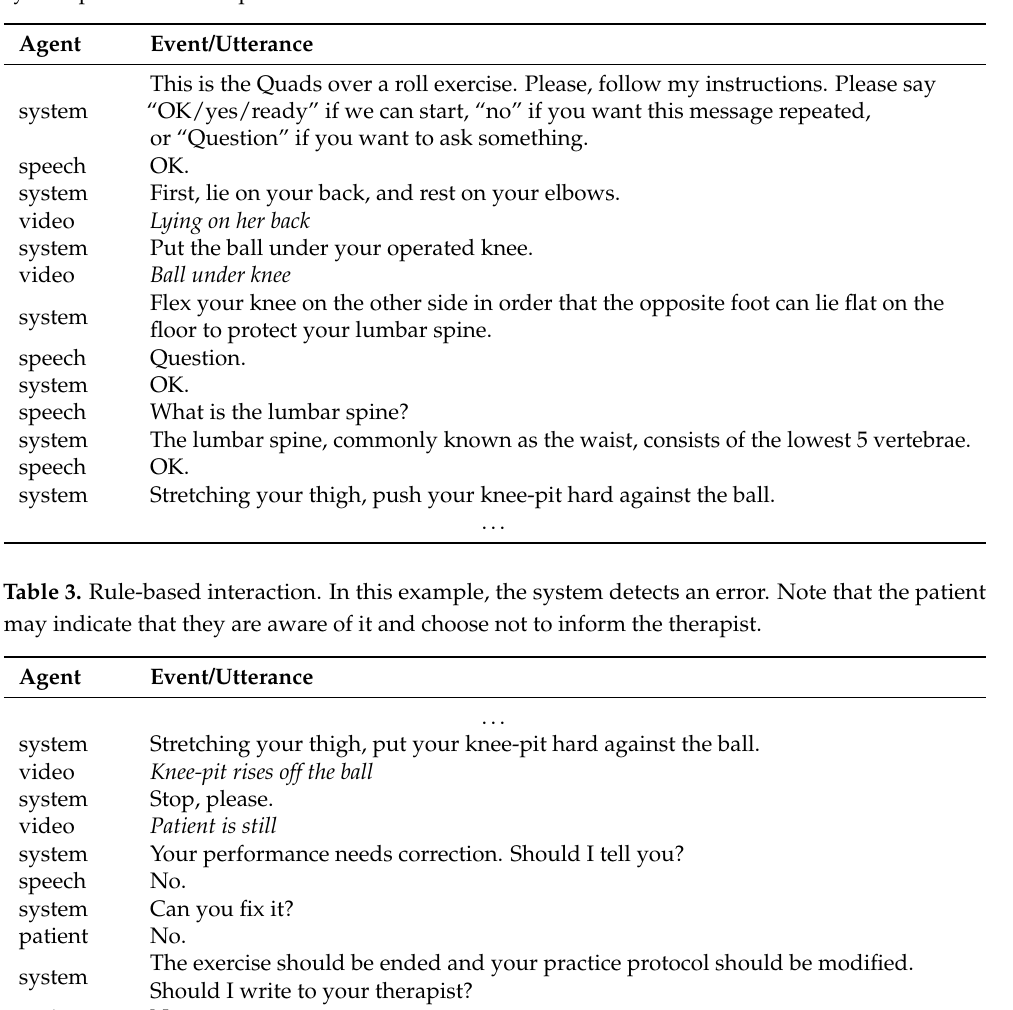
Table 2. Rule-based interaction. In this example, the patient is asking for information. Note that the system processes both speech and video events.